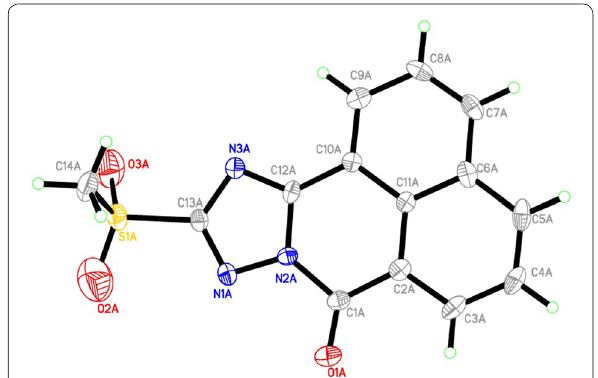
Fig. 3 ORTEP diagram of compound